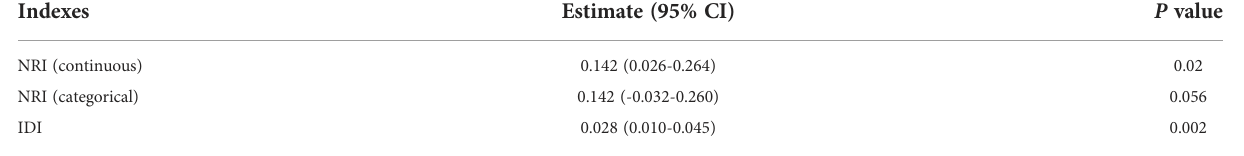
TABLE 2 Reclassi fi cation Indexes for Regression Models.